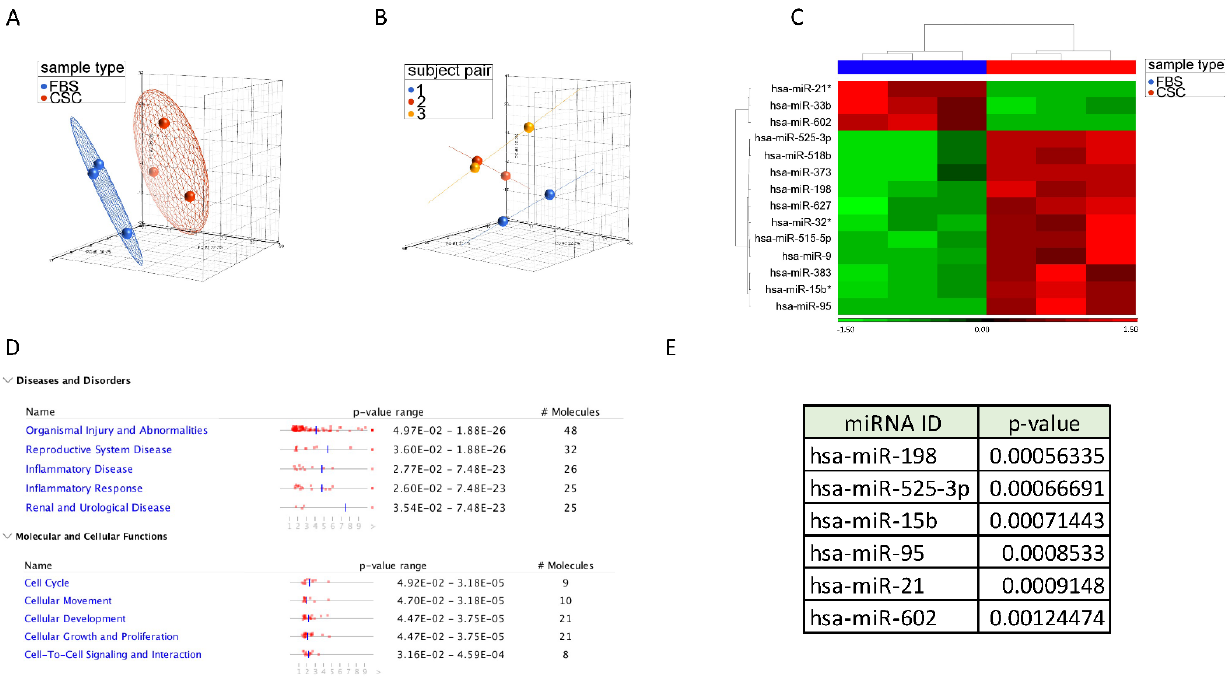
Figure 1. Principal Component Analysis (PCA) of CSC (in red) and FBS (in blue) samples based on the complete miRNA expression data set ( A ). Principal Component Analysis (PCA) of the samples according to their individual pair ( B ). Hierarchical clustering of the 14 significantly differentially expressed miRNAs ( p < 0.005); miRNAs marked with the asterisk (*) correspond to a less abundant form ( C ). Functional Interpretation analysis of 67 differentially expressed miRNAs at a statistical level of p < 0.05 ( D ). List of the 6 most significant differentially expressed miRNAs between CSC and FBS samples ( E ).